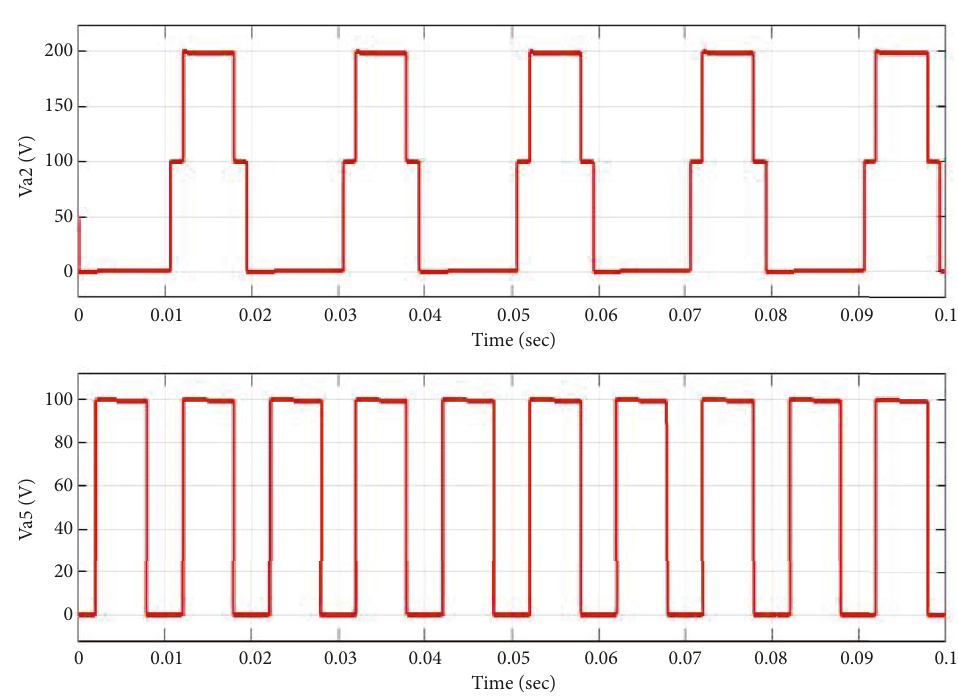
Figure 16: Voltage stress across the switches in